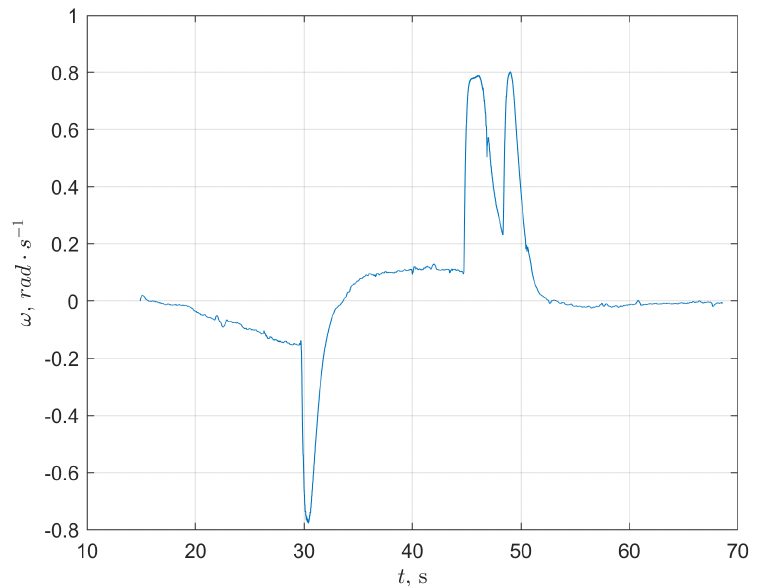
Figure 27. Changes in angular rate over time for the mid value of the cost function equal to 1.0858— track